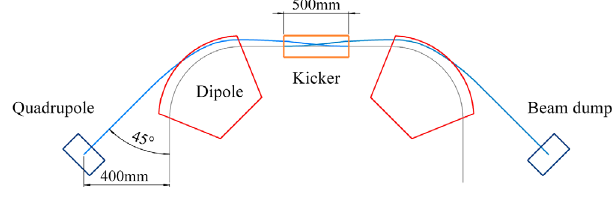
FIG. 9. Injection and extraction scheme.